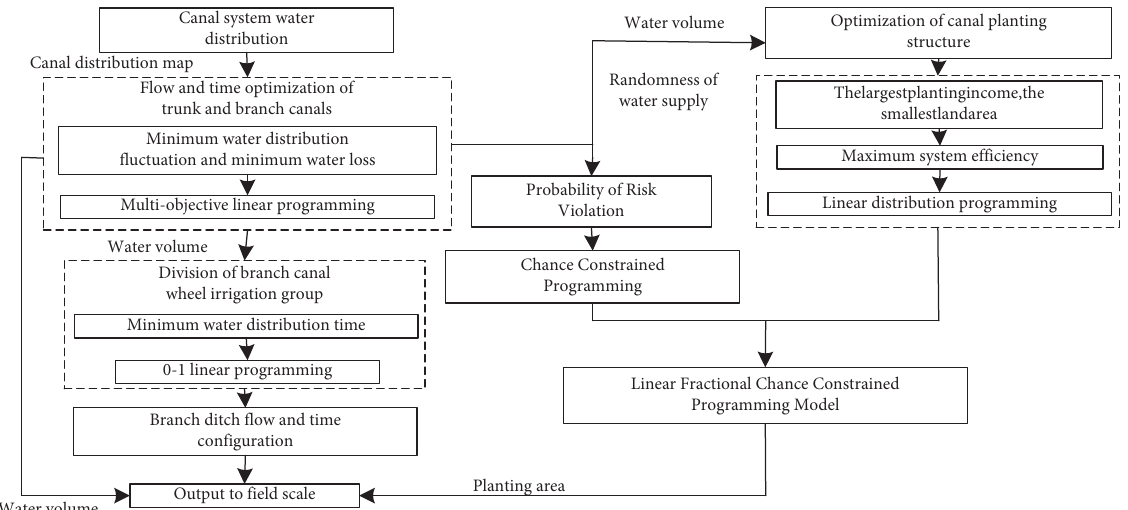
Figure 1: Schema of the proposed